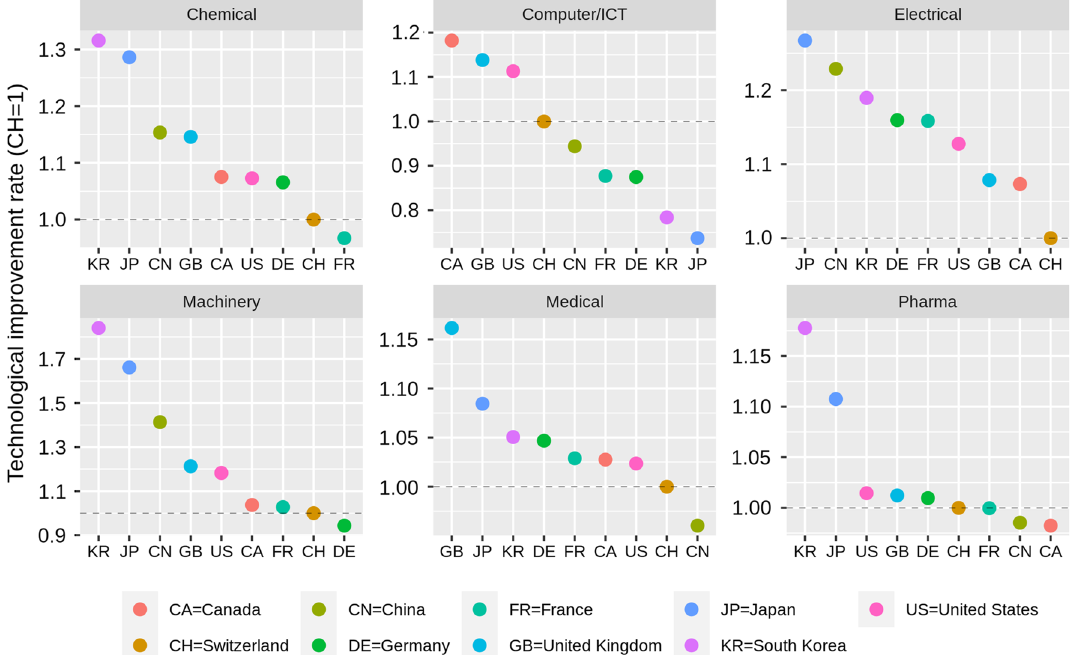
Fig. 10 Average technological improvement rates of all patents of different industries and countries. Notes : Calculations based on improvement rates of 1757 technologies taken from Singh et al. (2021) that were matched to USPTO patents between 2010 and 2015. The average technological improvement rate is normalized according to the value of